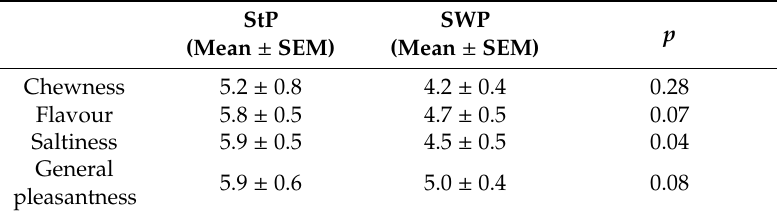
Table 3. Di ff erence in participants’ perception of chewiness, flavor, saltiness and general pleasantness between the two pizzas at the end of the